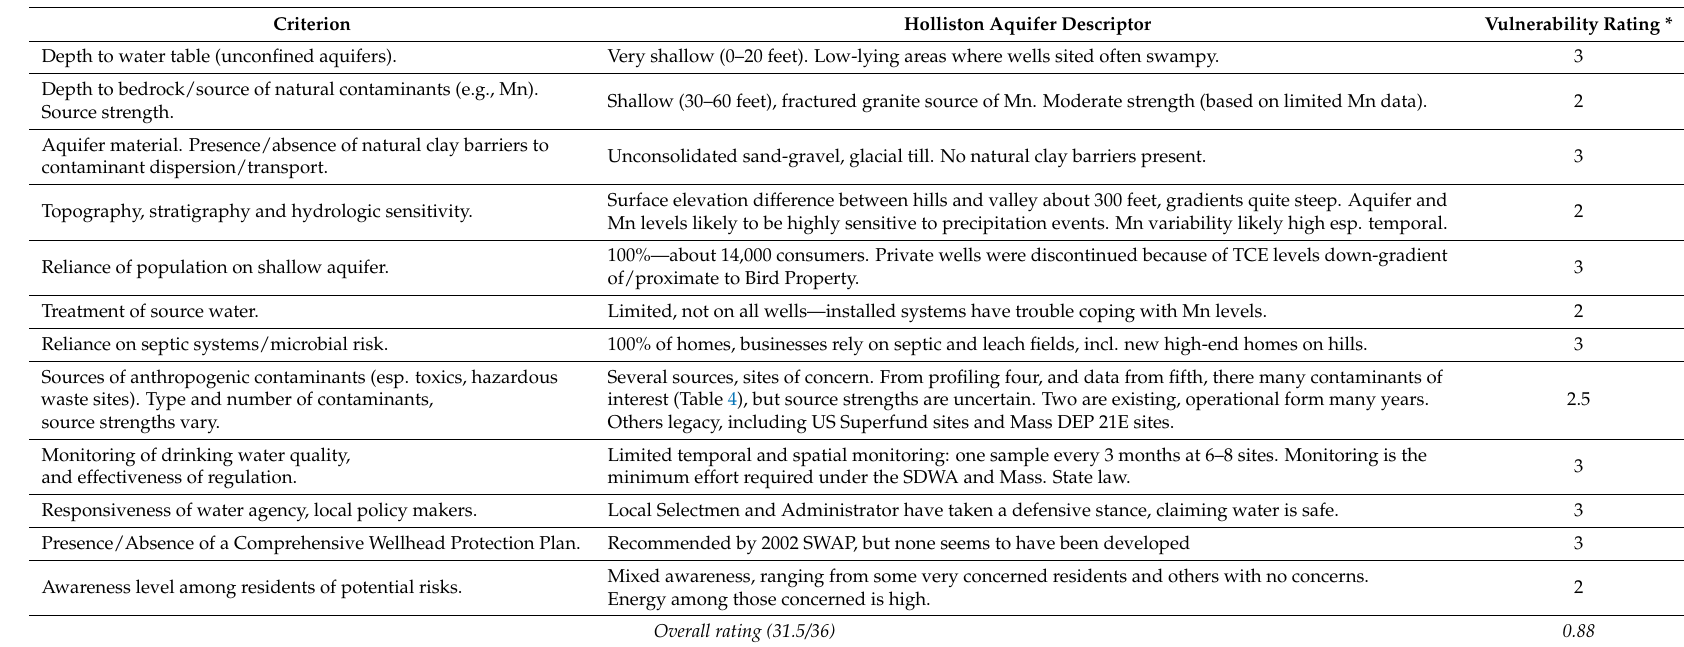
Table 5. Holliston aquifer vulnerability